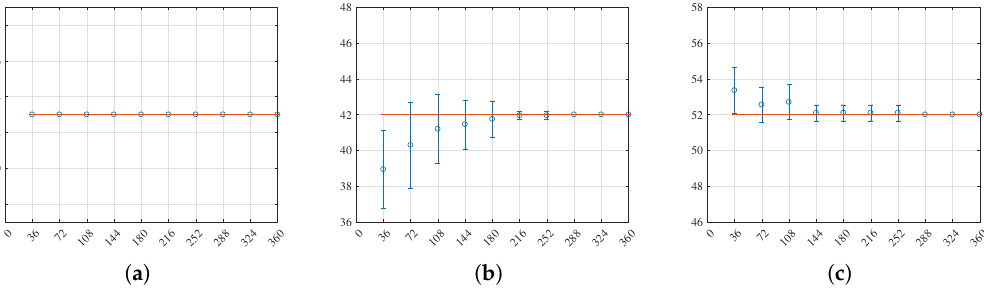
Figure 13. The estimated range and the number of used range profiles; ( a ) pins; ( b ) “ b ”-shaped metal pen inside a pencil case; and ( c ) cylindrical pencil vase with three metal